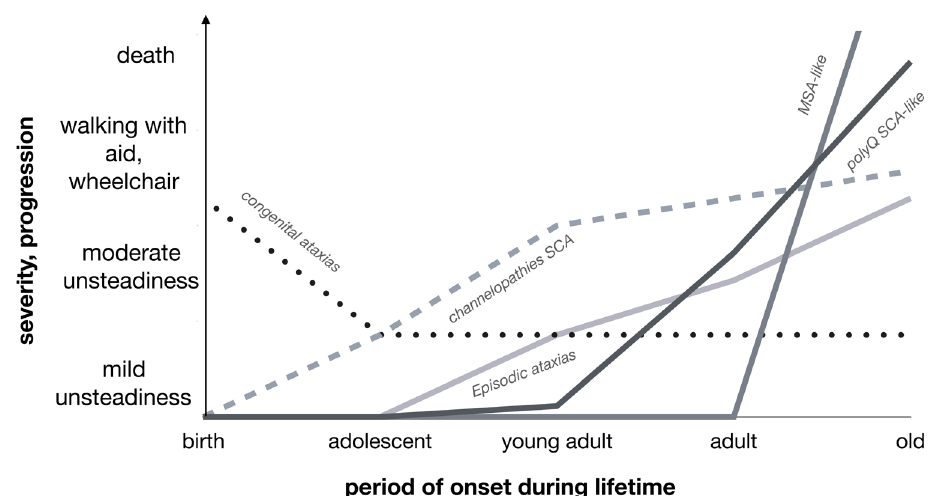
Figure 1. Progression and severity profiles in cerebellar ataxias by underlying etiology. Multisystem atrophy (MSA) is a rapidly progressing non-monogenic alpha-synucleinopathy. �t is the most se�ere o�� these diseases�� ��ollo�ed �y polyglutamine (poly�) spinocere�ellar ataxias (SCAs)�� such as ATXN1/SCA1, ATXN2/SCA2, ATXN3/SCA3, CACNA1A/SCA6, ATXN7/SCA7, TBP/SCA17 , and ATN1/DRPLA . Very di����erent profiles are present in the ��orms �ecause o�� missense mutations in channel genes ( CACNA1A , KCND3 , KCNC3 , and KCNA1 )